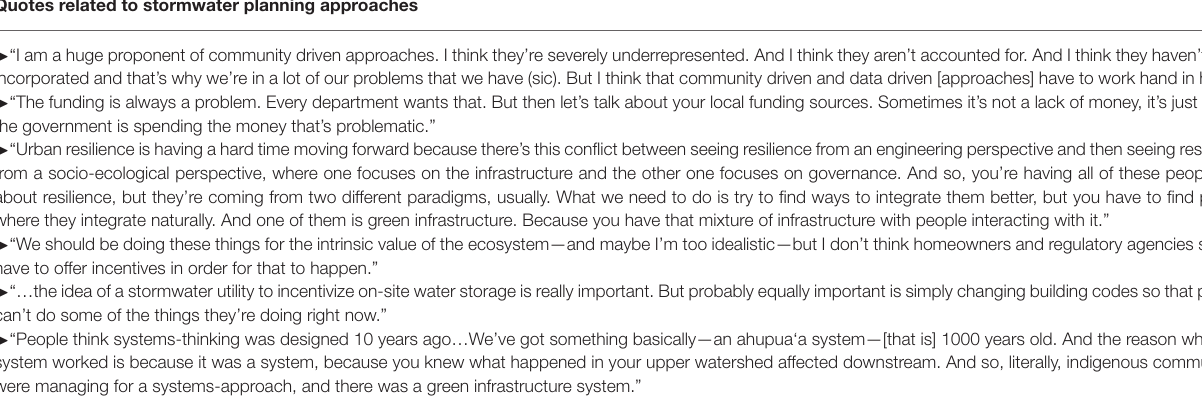
TABLE 11 | Notable quotes from study participants regarding their ideas about stormwater planning